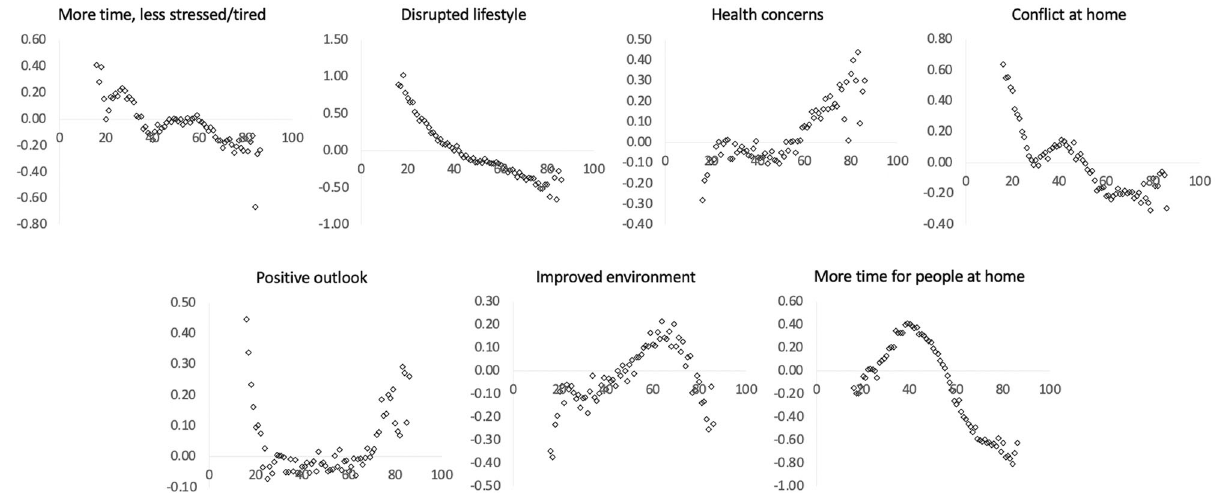
Fig. 6 Self-perceived pandemic impact by age. There were large associations between peoples ’ ages and self-perceptions of the ways that they had been affected by the pandemic ( X axes = age, Y axes = component scores in SD units). Source data are provided as a Source data fi le.